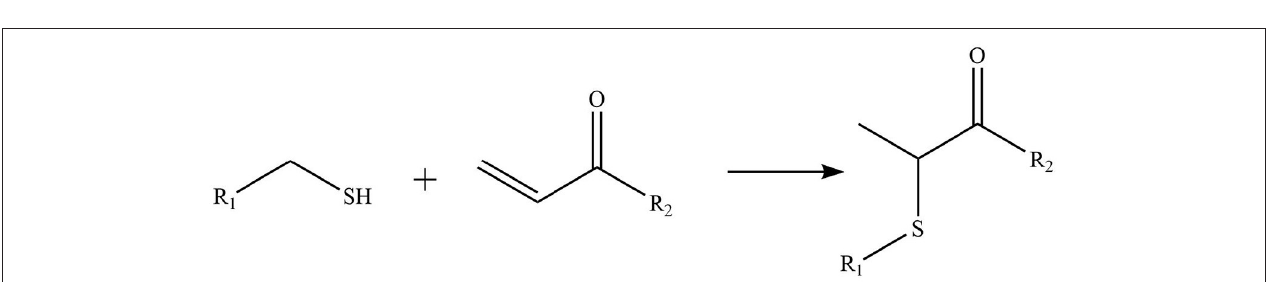
FIGURE 1 | Potential TLR4 signaling pathway induced by phytochemicals.